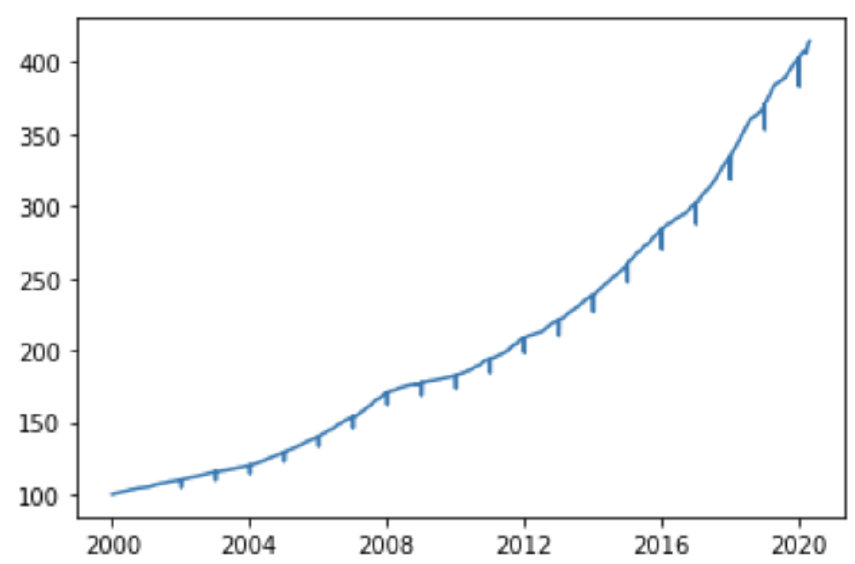
Figure 16. Average of the returns over 10,000 scenarios with the VolTarget portfolio with historical volatility (source: authors’ calculations).